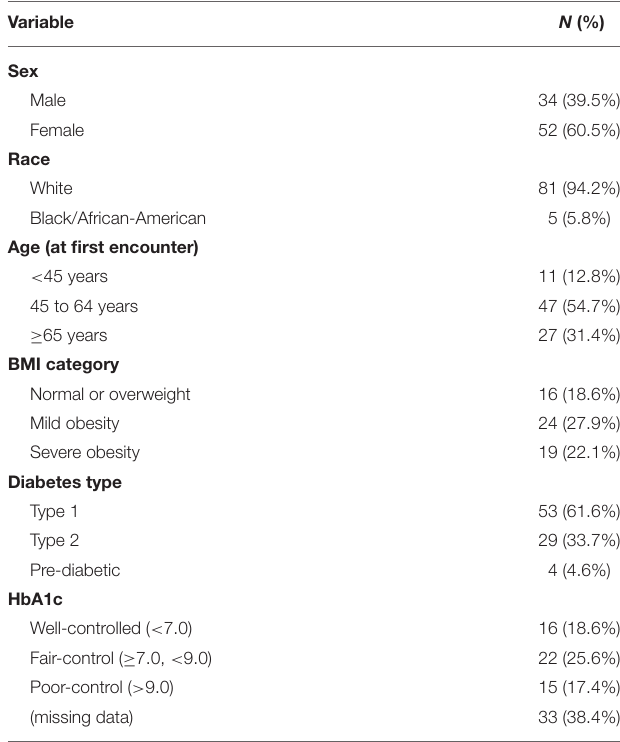
TABLE 3A | Descriptive statistics—self-report/subjective data (categorical variables).